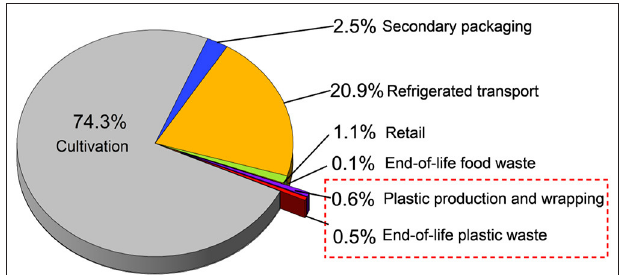
FIGURE 2 | Contribution of each life cycle stage of scenario 2 (supply chain for cucumbers with plastic wrapping) to the climate change impact of the entire cucumber import supply chain, from grower to grocer. The contribution of the plastic wrapping toward the environmental impact is highlighted in the red dotted